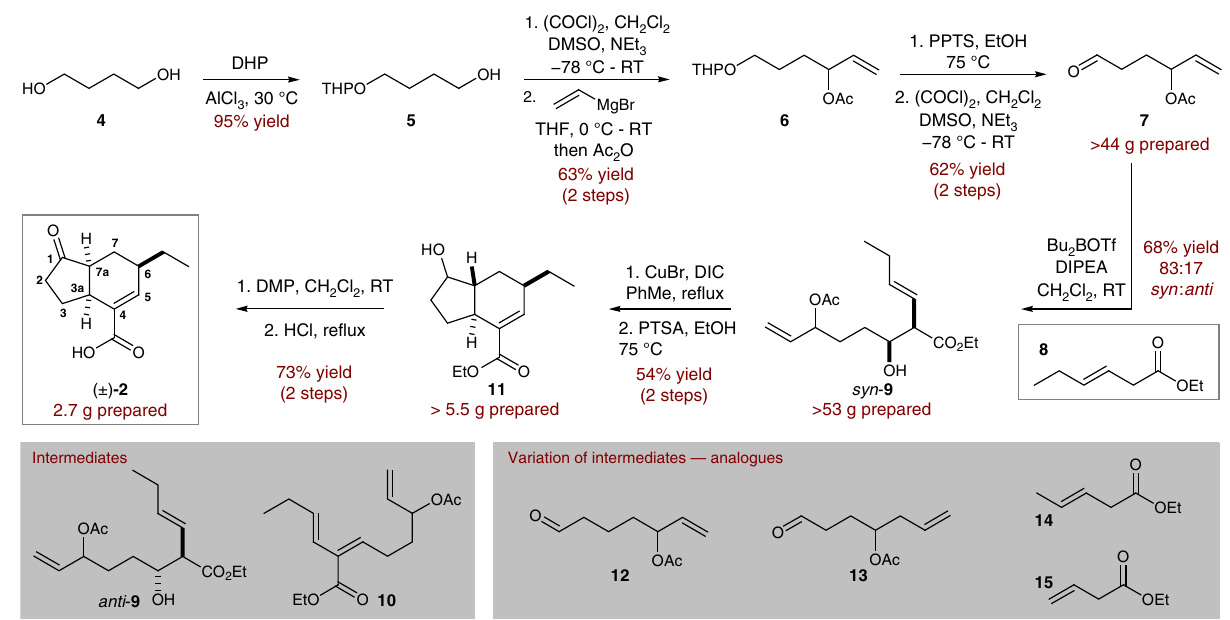
Fig. 2 Gram-scale synthesis of (±)-CFA. Five step synthesis of aldehyde 7 , followed by syn -selective room temperature aldol addition with ester 8 . Aldol addition product 9 undergoes dehydration and IMDA cyclization of the resultant triene at elevated temperature. DHP: dihydropyran, DMSO: dimethyl sulfoxide, PPTS: pyridinium p -toluenesulfonate, DIPEA: N , N -diisopropylethylamine, DIC: N , N ’ -diisopropylcarbodiimide, PTSA: p -toluenesulfonic acid, PDC: pyridinium